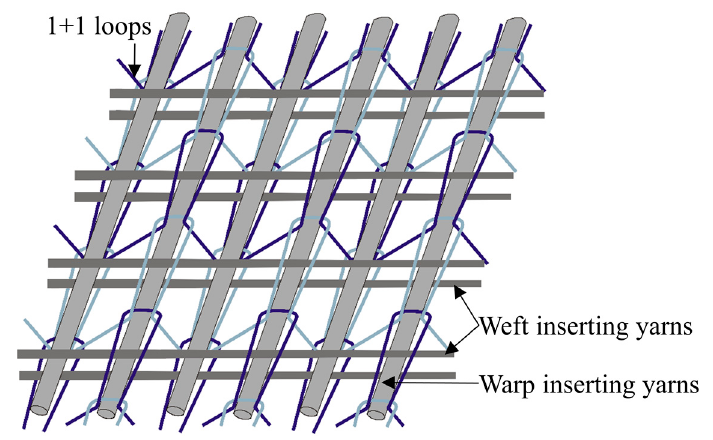
Figure 1. MBWK structure with three layers of inserting yarns. Table 1. Specification of inserting yarns.